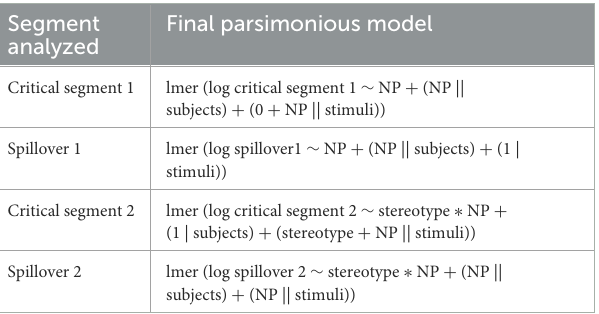
TABLE 6 Resulting parsimonious models for reading times on the three analyzed segments of Experiment 2.